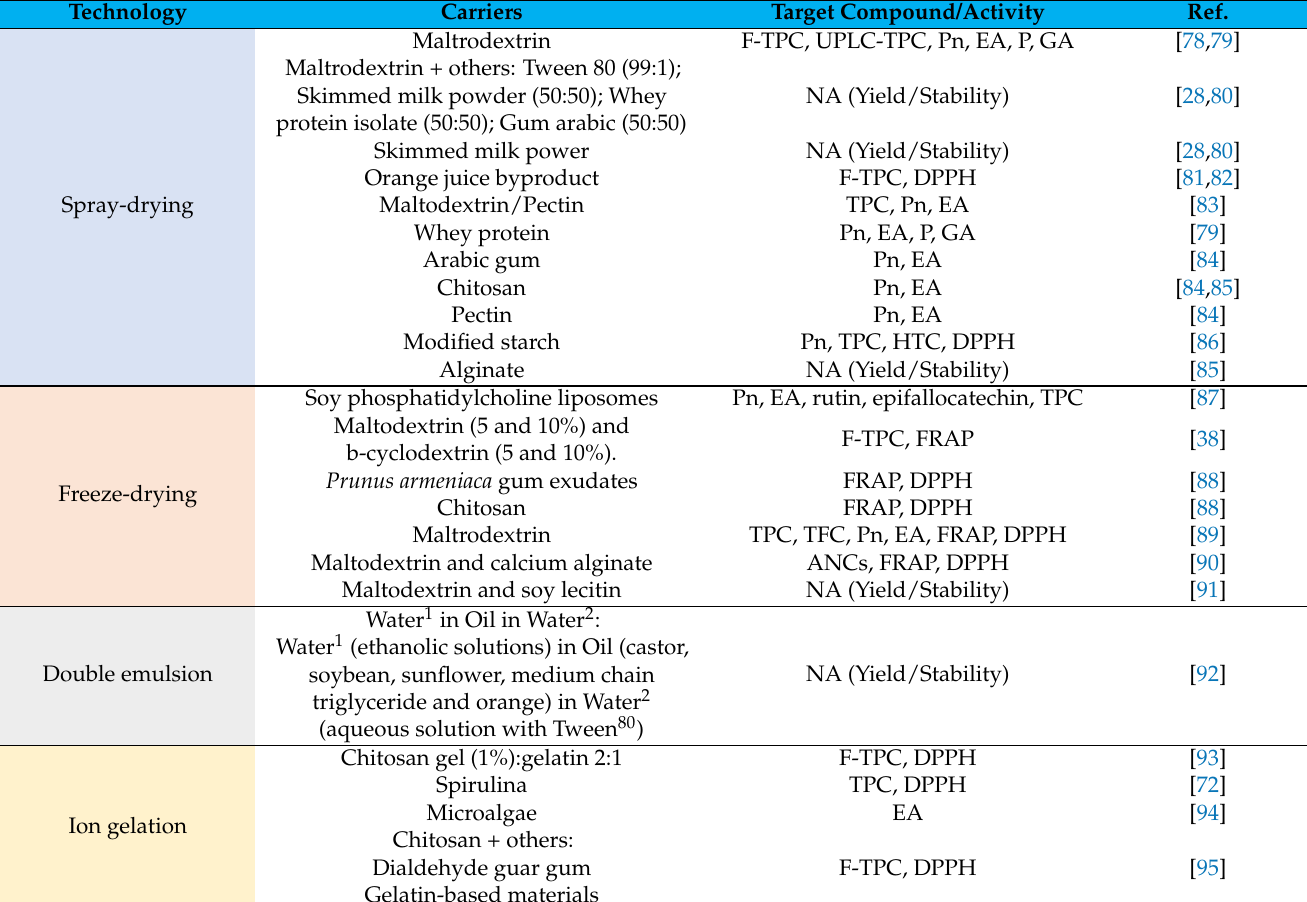
Table 4. Main technologies used to encapsulate target compounds from pomegranate peel.